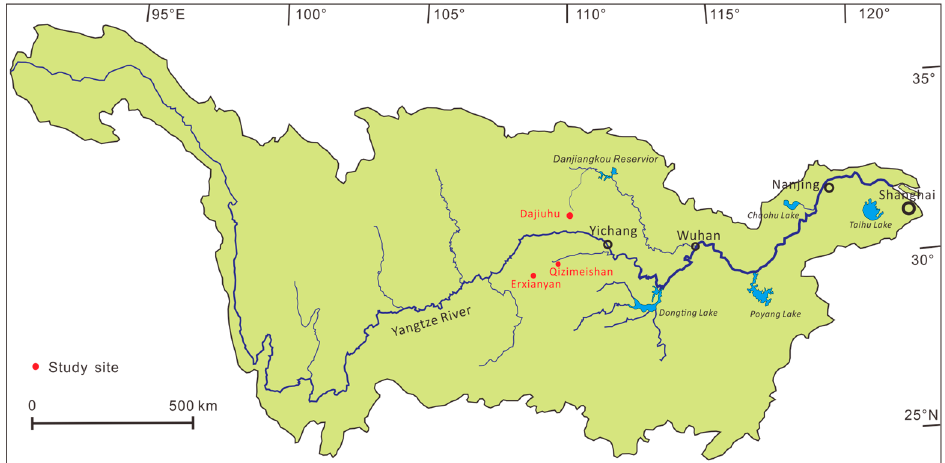
Figure 1. Location of the three peatlands in the Yangtze basin.